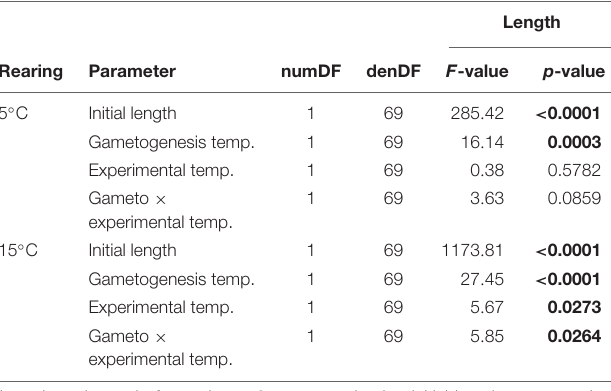
Frontiers in Marine Science |